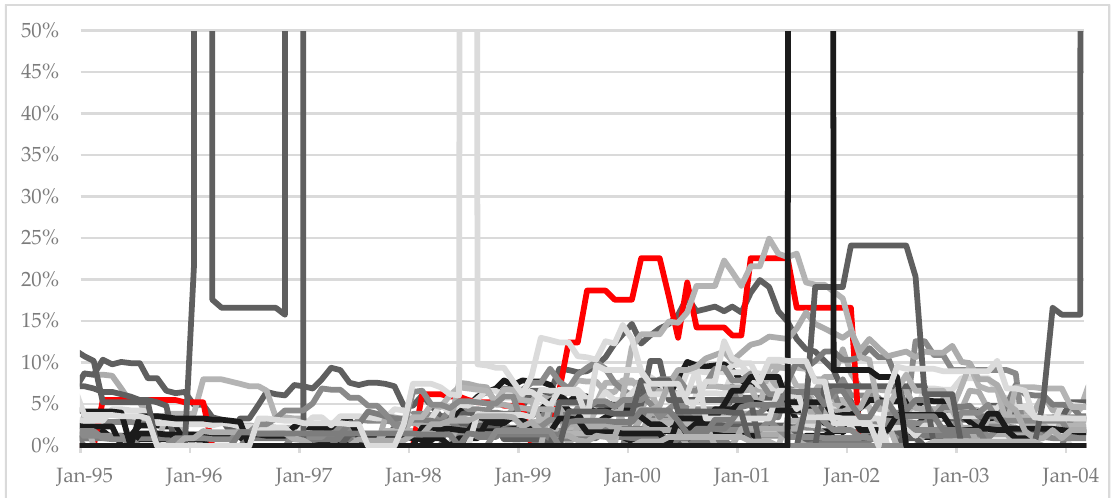
Figure 5. Sectoral default rates around the early 2000s downturn in credit conditions. Source: Author’s calculations and Moody’s. Note that the exhibit presents sectoral default rates for 33 non-financial corporate sectors. The vertical axis was deliberately limited to 50% to illustrate volatility within and across sectors relative to lower default rates in some time periods. The “environmental services” sector is highlighted in red, as it is the first sector that saw its default rate jump sharply and persist higher during the course of 1999/2000.